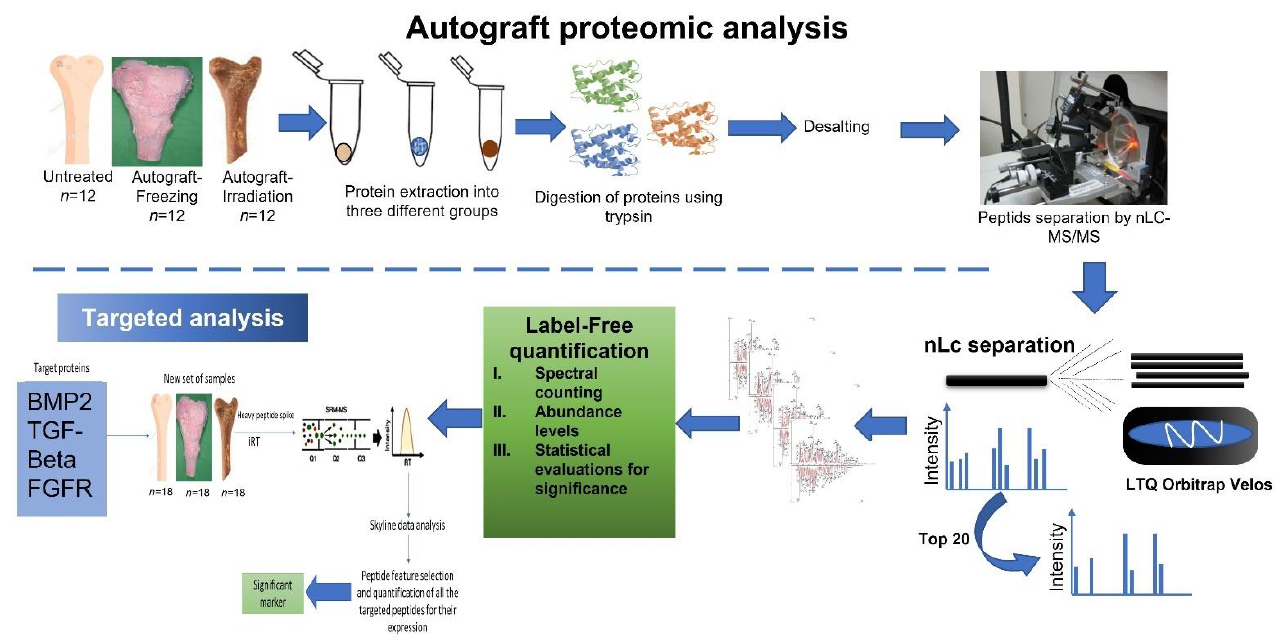
Figure 1. High-grade osteosarcoma untreated, freezing-treated, and irradiation-treated autografts target proteomic analysis workflow.